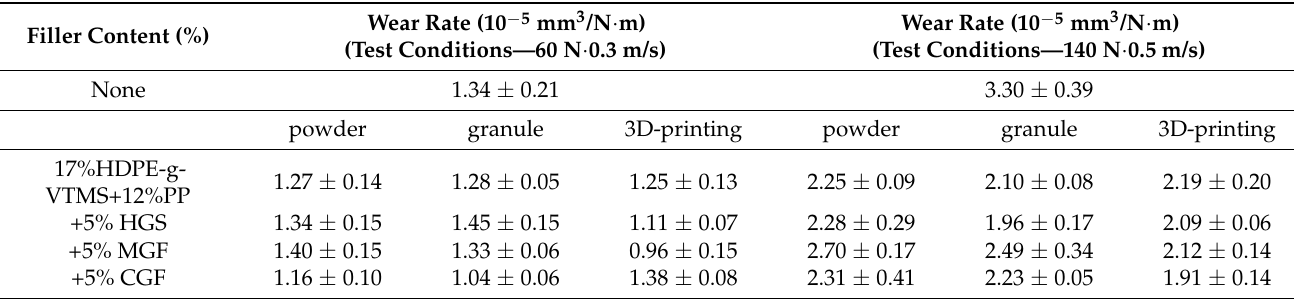
Table 7. The tribological characteristics of neat UHMWPE and the ‘UHMWPE+17%HDPE-g-VTMS+12%PP’-based compos- ites. The ‘block-on-ring’ scheme.